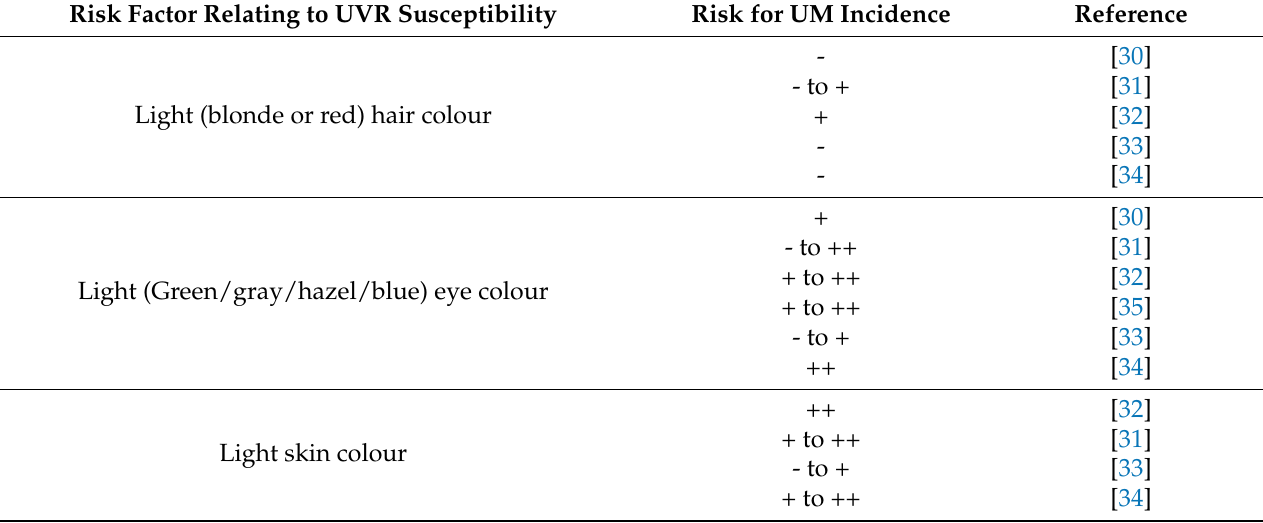
Table 1. UVR-related risk factors associated with UM in the Northern Hemisphere and in Australia. Risk Factor Relating to UVR Susceptibility Risk for UM Incidence